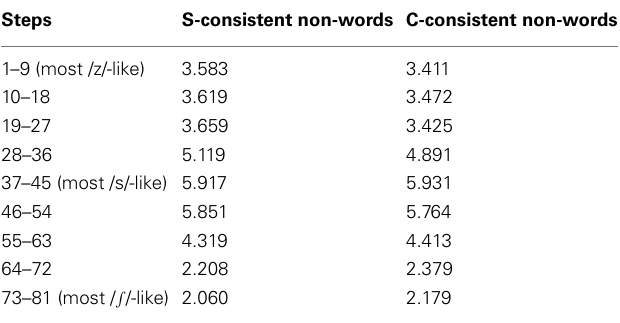
Table 4 | Experiment 3: mean ratings byAustralian listeners for non-words with S- versus C-consistent lexical analogs, across nine 9-step portions of the 81-step continuum from /z/ through /s/ to / ∫